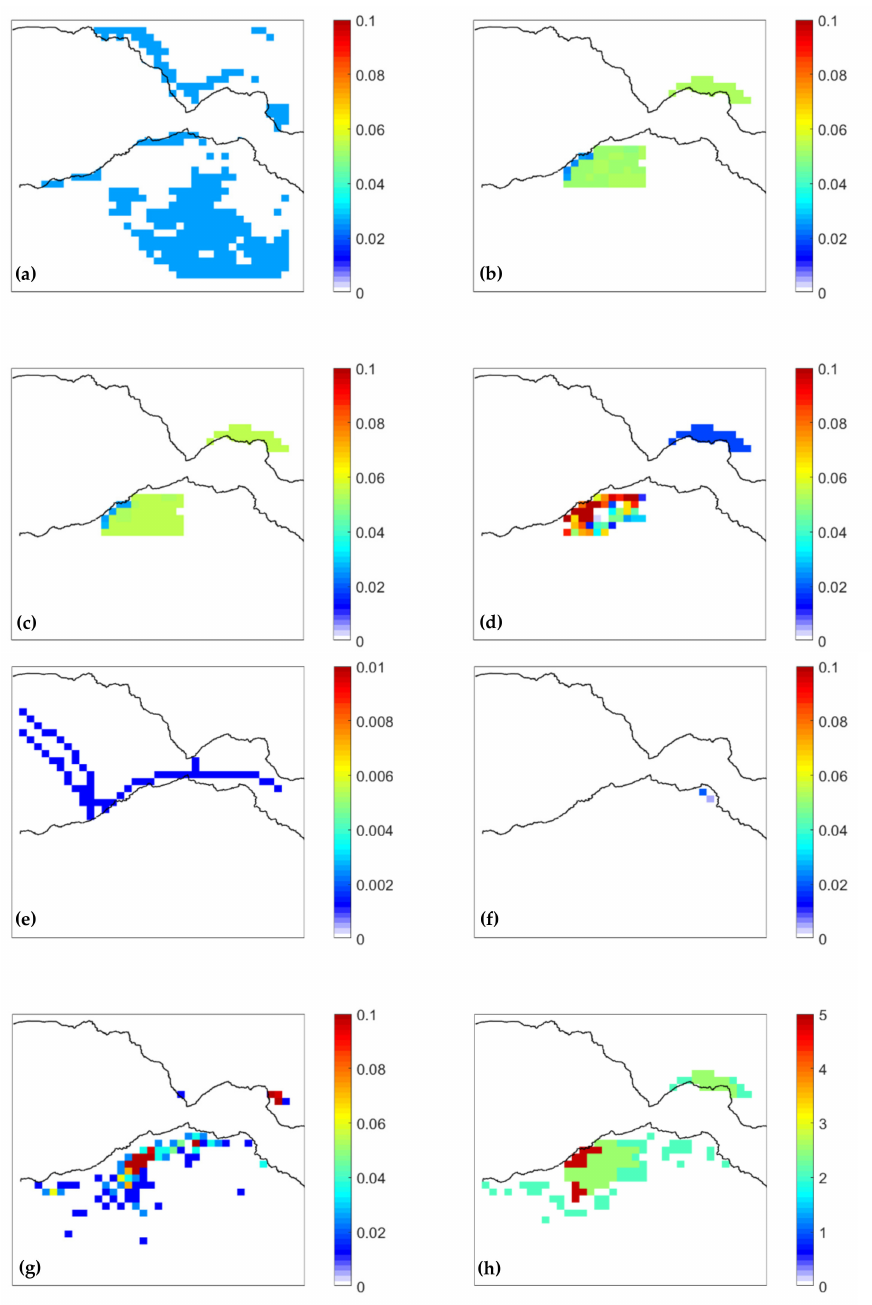
Figure 3. Total PM 10 emissions (tn km − 2 ) from ( a ) agriculture, ( b ) domestic processes, ( c ) non-road transport, ( d ) road transport, ( e ) shipping, ( f ) industry, ( g ) cooking and ( h ) biomass burning during December 2021 for the inner domain including the city of Patras. Different scales are used. The agricultural emissions (SNAP 10) are evenly distributed to the agricultural and range land 1 × 1 km 2 resolution grid cells. The corresponding emissions and their spatial distribution are shown in Figure